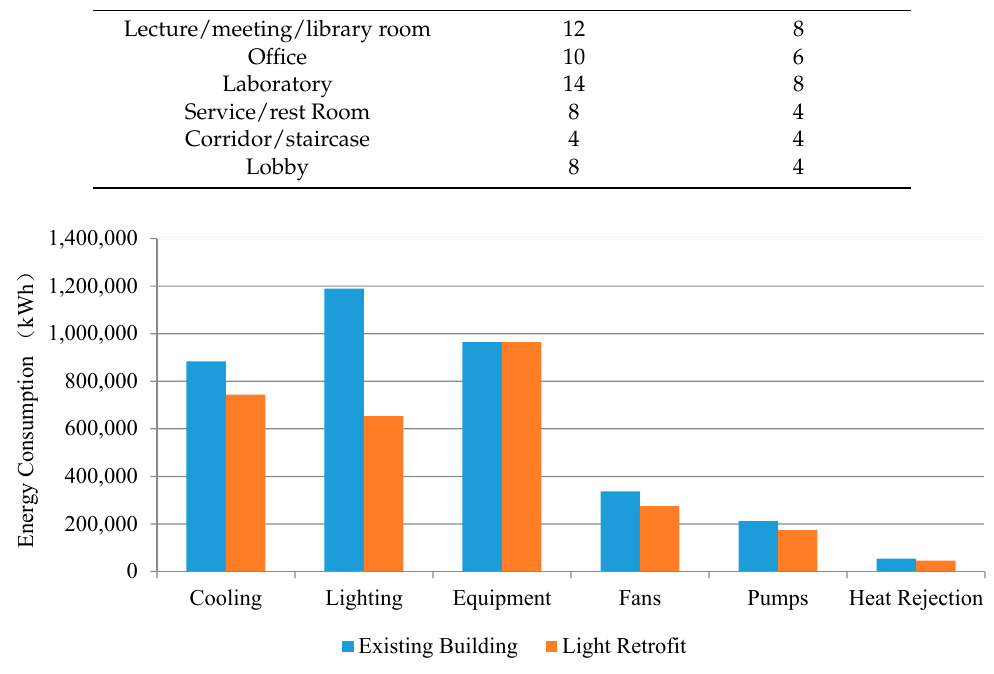
Figure 5. Annual energy consumption before and after the lighting retrofit.